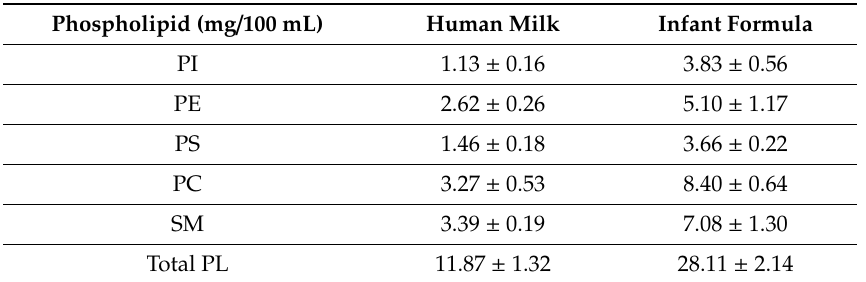
Table 3. Distribution and absolute concentrations (mg / 100 mL ± SE) of di ff erent phospholipid (PL) classes in human milk and infant formula